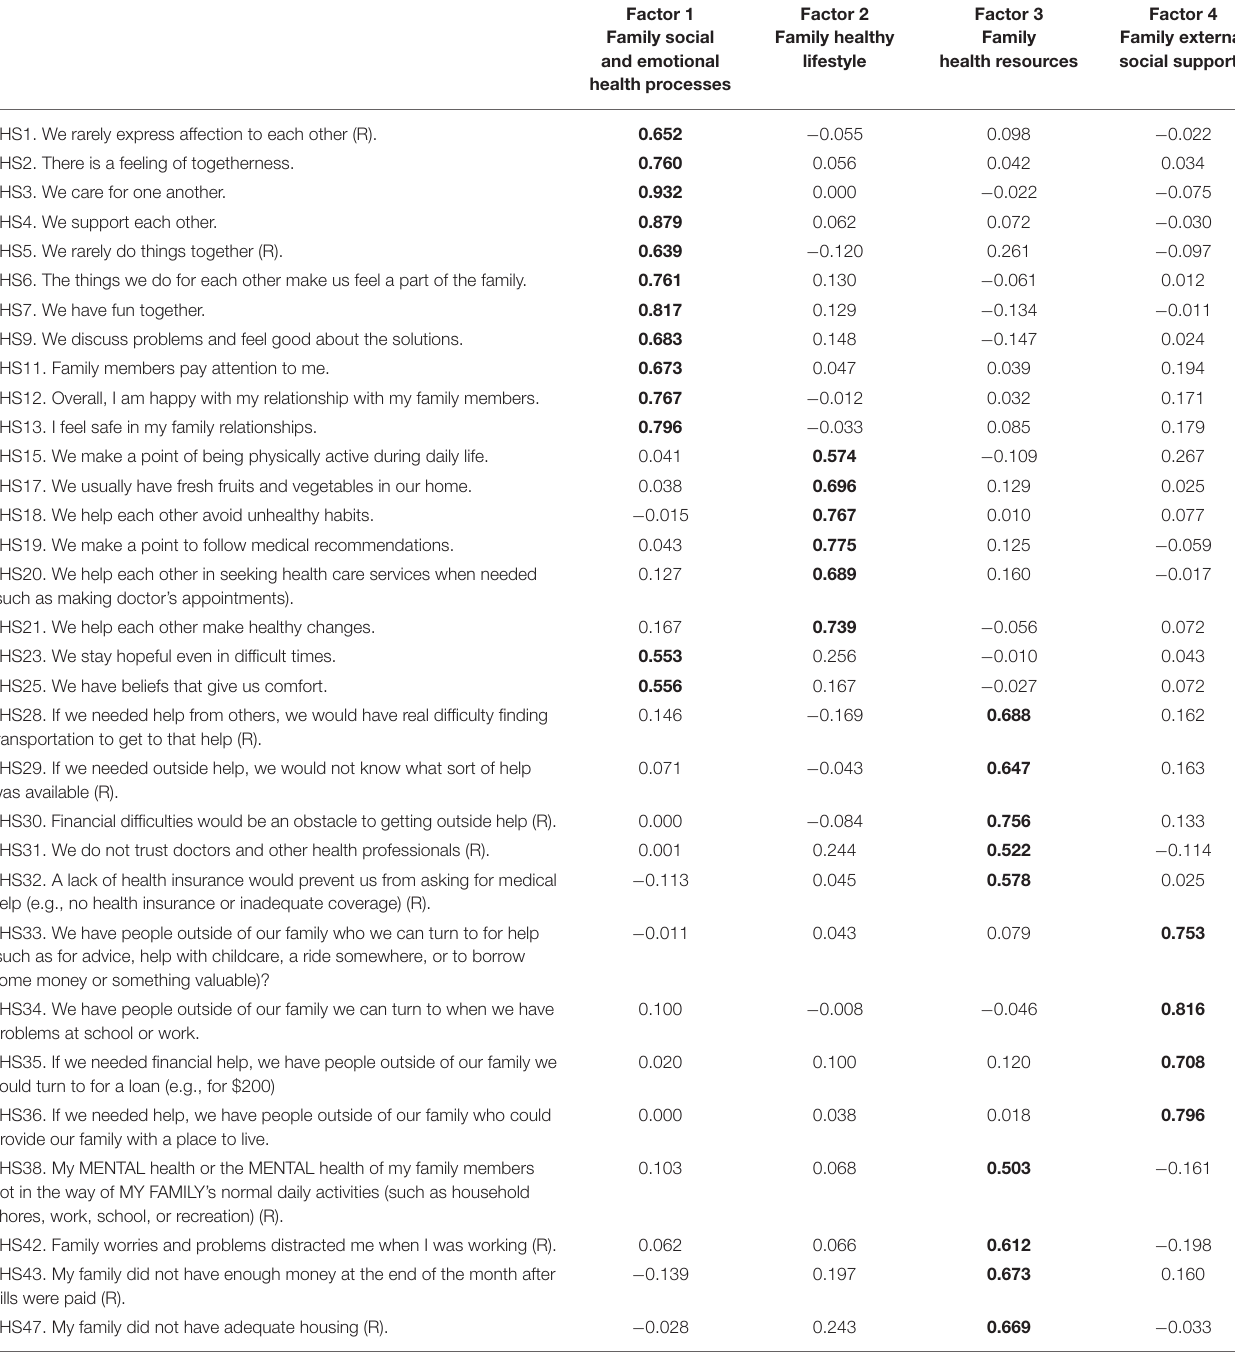
TABLE 2 | Exploratory factor analysis results of the FHS-LF, n = 350 (RMSEA = 0.061; CFI = 0.960).